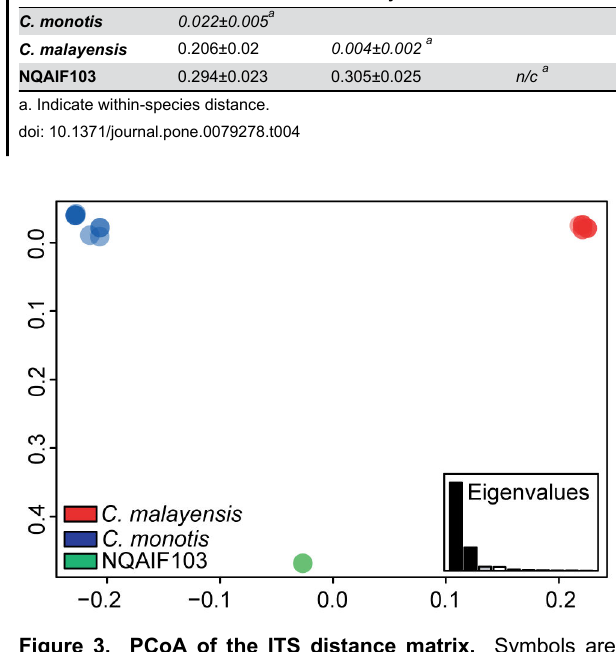
Figure 3. PCoA of the ITS distance matrix. Symbols are partially transparent to enable visualisation of higher density of points via colour saturation. doi: